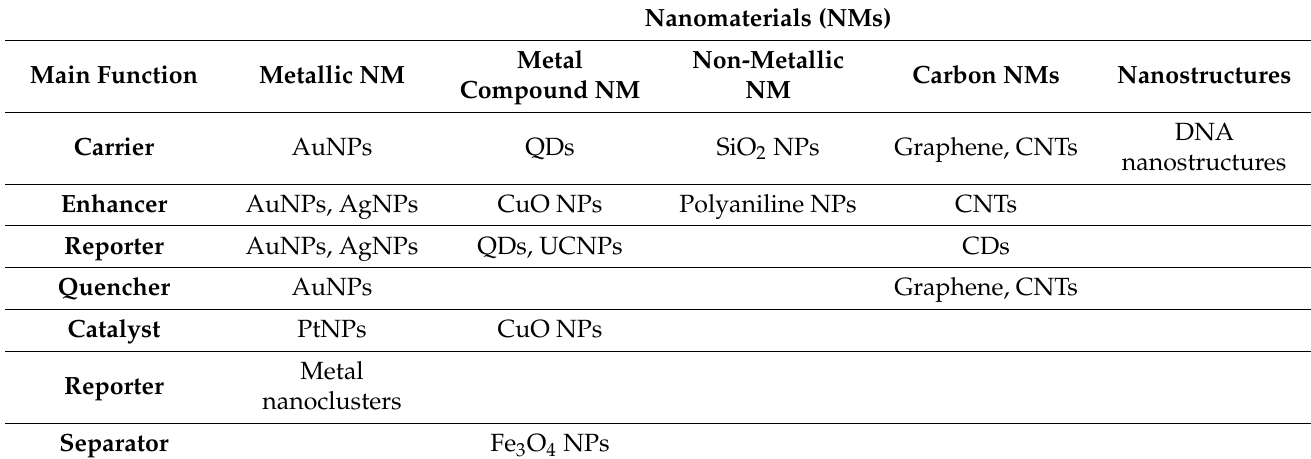
Table 1. Summary of types and functions of nanomaterials. Adapted from reference [48]. This article is an open access article distributed under the terms and conditions of the Creative Commons Attribution (CC-BY) license (http://creativecommons. org/licenses/by/4.0/ (25 March 2021)).